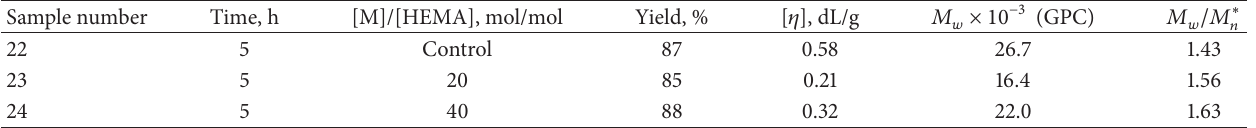
Table 6: Effects of polymer yield, reaction time, and product intrinsic viscosity on